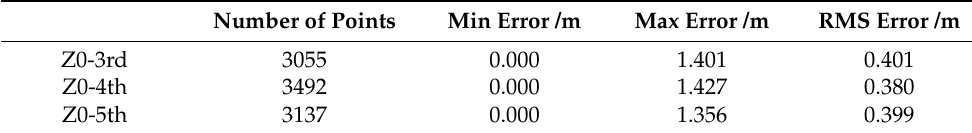
Table 1. Coplanar error statistics of laser footprints before geometric calibration. Number of Points Min Error /m Max Error /m RMS Error /m Z0-3rd 3055 0.000 1.401 0.401 Z0-4th 3492 0.000